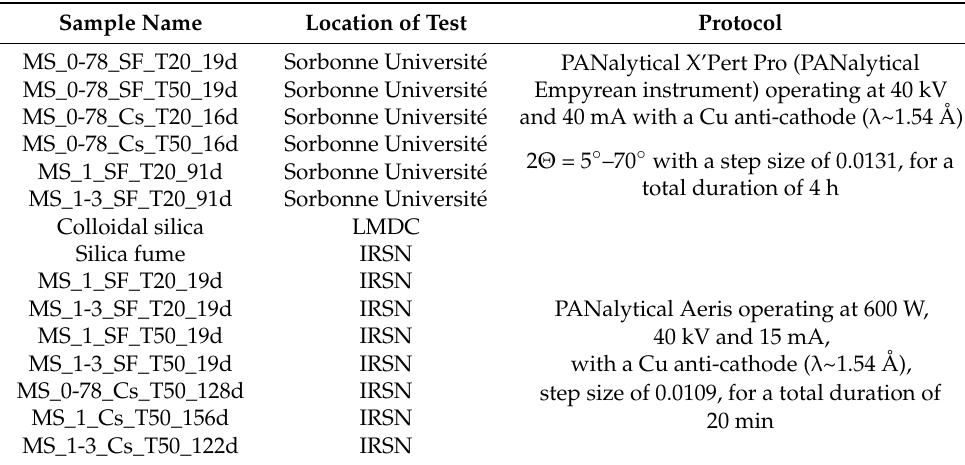
Table 2. Protocol used on samples in X-ray